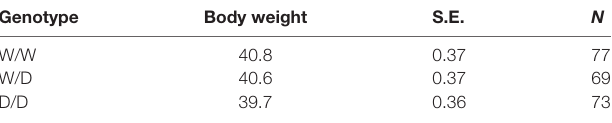
TABLE 3 | Body weight (g) of newly hatched chicks of three genotypes (W/W, W/D and